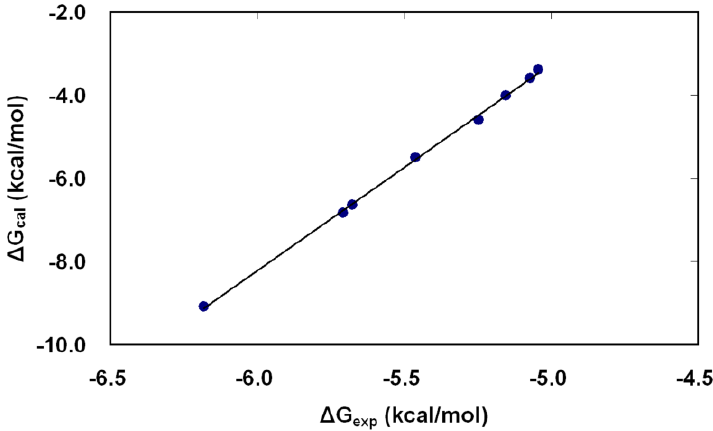
Figure 5. The correlation between the free energies of binding of inhibitors (Bz1–Bz8) as calculated by molecular dynamics in combination with the PB-SASA method (Δ G calculation) versus those derived from the experimental data of Krauser et al. (Δ G experiment) [14]. The lowest binding free energy estimate from the five different poses simulated for each inhibitor is plotted against the corresponding value calculated from experimentally determined K -values. i